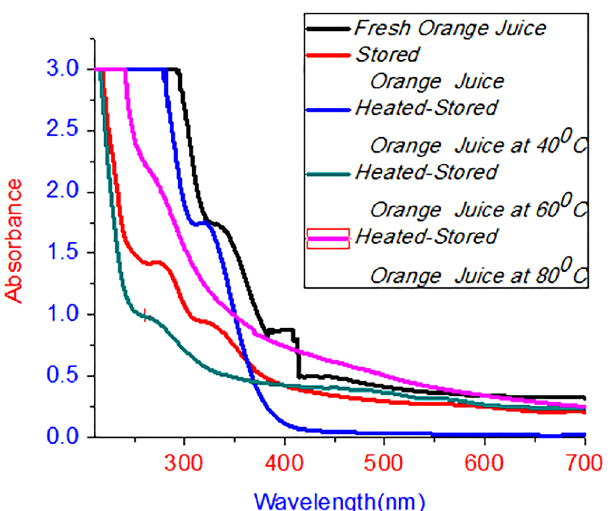
Figure 3. UV/vis absorption spectra of orange